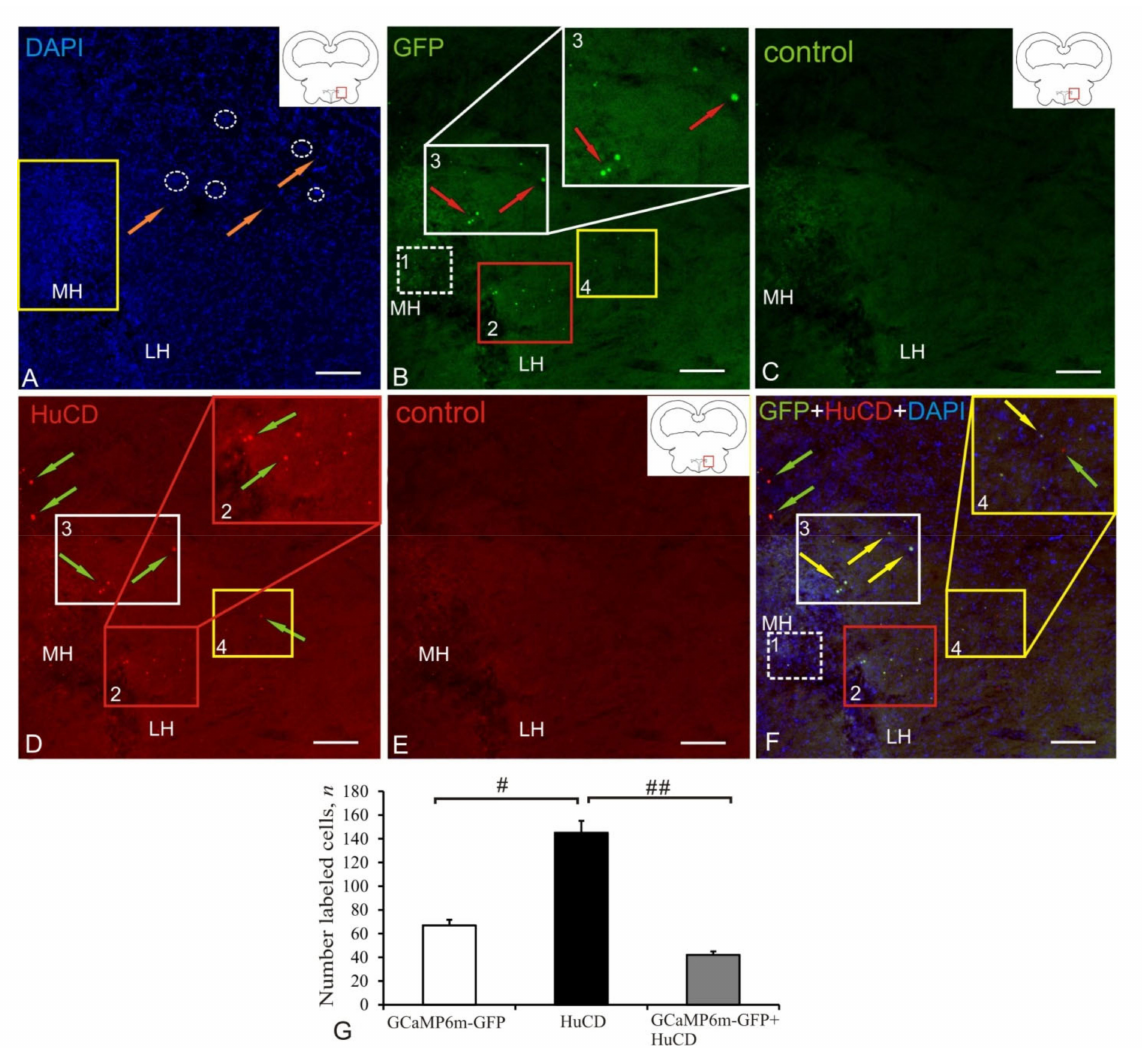
Figure 1. Z-stacks representing HuCD immunolabeling in the anterior hypothalamic ventricle of juvenile chum salmon, O. keta , at 1 week after a single injection of recombinant AAV in the mesencephalic tegmentum area. ( A ) DAPI staining; the pictogram shows the area of the anterior hypothalamus (outlined by red rectangle); the yellow rectangle outlines an aggregation of nuclei of the medial hypothalamus (MH), stained nuclei (orange arrows); LH is the lateral hypothalamus; constitutive clusters of nuclei are outlined by the white oval dotted line. ( B ) Expression of the green fluorescent protein (GFP) in hypothalamic cells (red arrows); the white dashed rectangle outlines cluster 1 in the medial zone; other boxes show clusters of 2, 4, and 3 (with inset at higher magnification) GFP+ cells in the lateral zone of the hypothalamus. ( C ) Control brain sections; in the animals that received an injection of 0.1% PBS, GCaMP6m-GFP was not labeled. ( D ) Immunofluorescence of the HuCD protein in hypothalamic neurons (green arrows); cluster 2 is shown with inset at higher magnification. ( E ) Control brain sections; in the animals with the lack of secondary antibodies, no HuCD immunolabeling was detected. ( F ) Superposition of three channels of DAPI/GFP/HuCD staining, showing the areas of GFP/HuCD colocalization in neurons (in the red rectangle). Laser scanning confocal microscopy. Scale bar: 200 µ m. ( G ) Results of one-way analysis of variance (ANOVA test) showing the comparative distribution of labeled cells and nuclei (M ± SD, where M is the mean and SD is the standard deviation) of the anterior hypothalamic ventricle of chum salmon. Significant intergroup differences were found between groups of GCaMP6m-GFP+ and HuCD+ cells (# < 0.05), as well as between GCaMP6m-GFP+ and GCaMP6m-GFP+/HuCD+ cells (## < 0.01) ( n = 5 in each